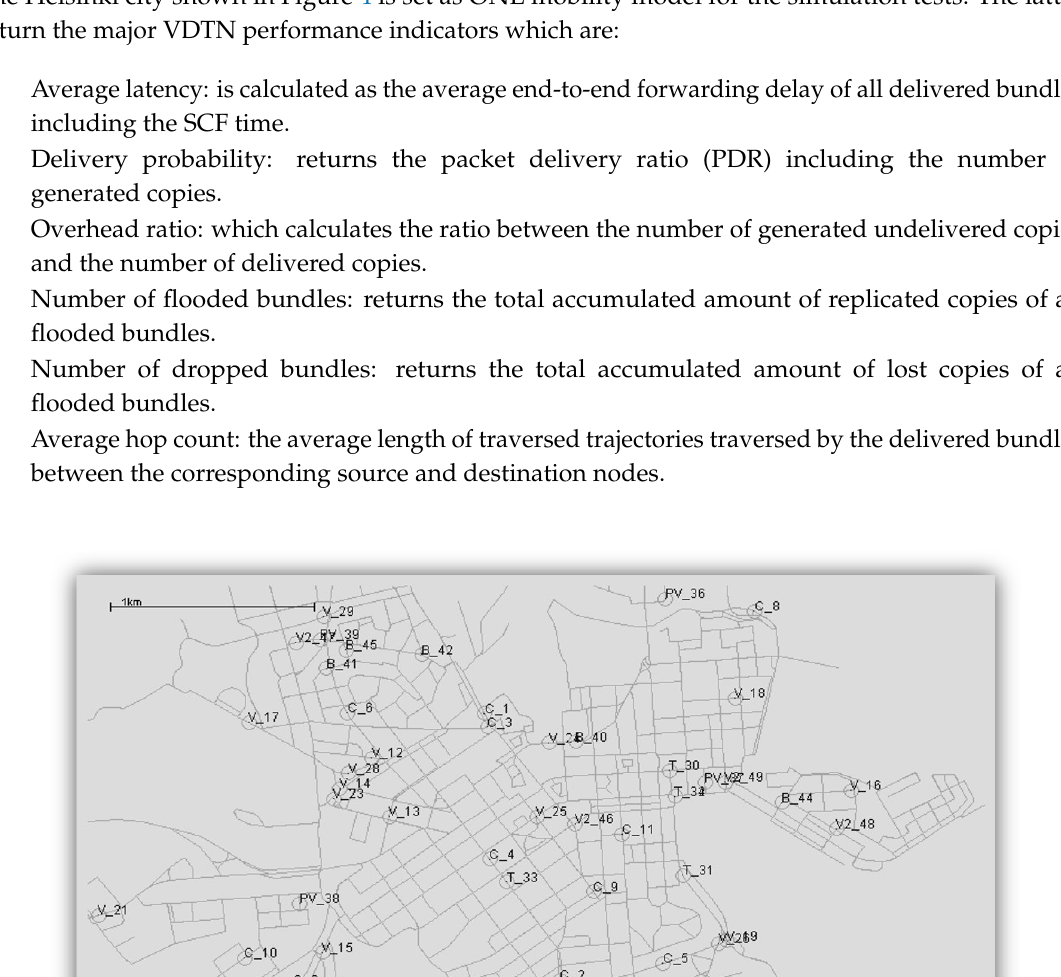
Figure 4. Simulation of Helsinki downtown mobility model.